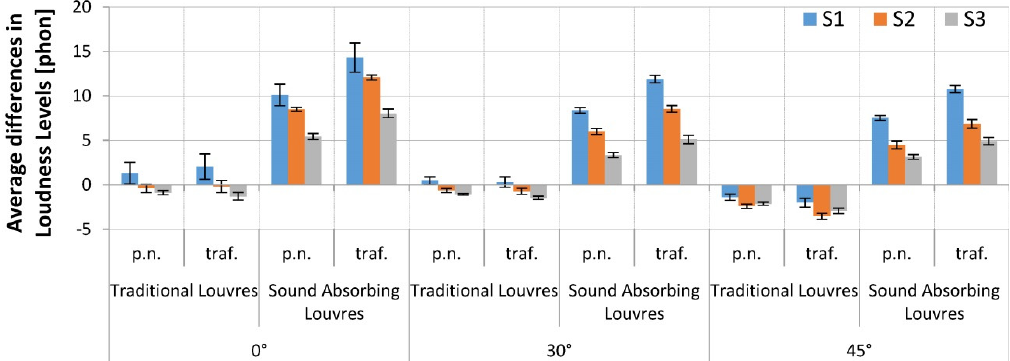
Figure 7. Average differences in Loudness levels due to the presence of the traditional louvres compared to the sound absorbing louvres. The bars in the figure are listed according to the source positions used for the measurements (S1, S2, and S3). Error bars report the doubled standard deviations for each average. The acronym “p.n.” refers to the pink noise signal. The abbreviation “traf.” refers to the standard traffic noise.